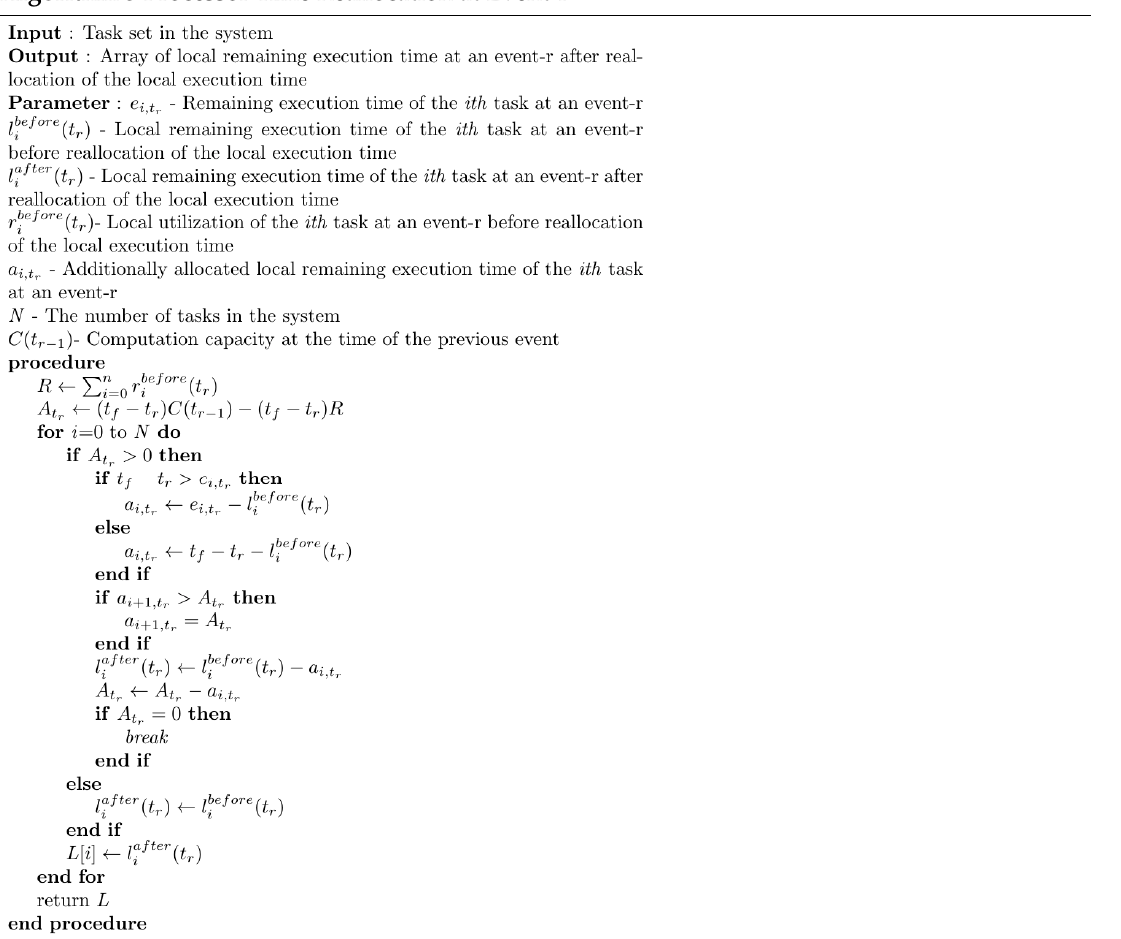
Algorithm 3 Processor Time Reallocation at Event-r